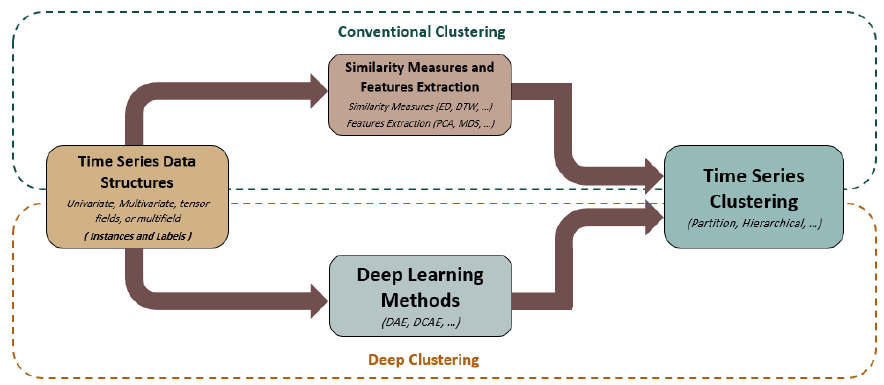
Figure 1. The review framework of both conventional and deep time-series